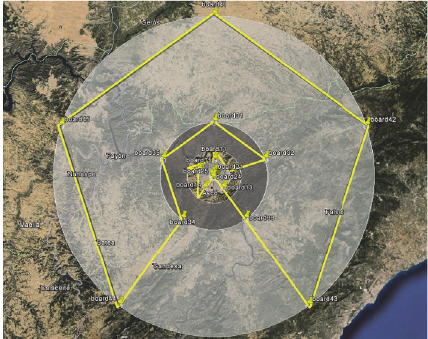
Figure 5: Flight plan 1. RPAS flies all the